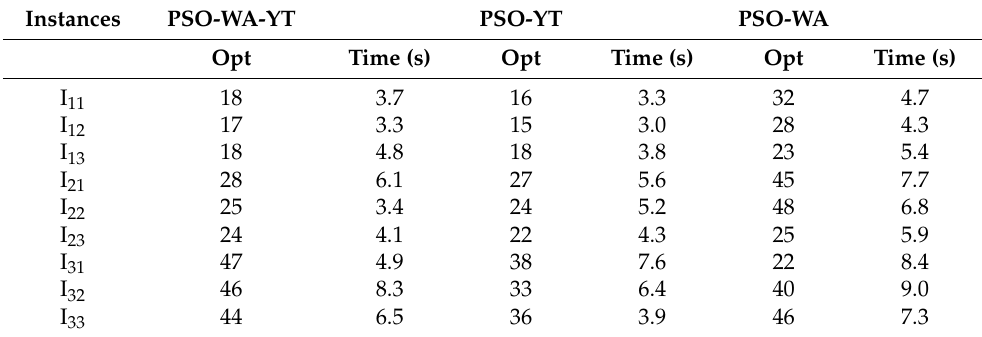
Table 5. Table corresponding to the parametric